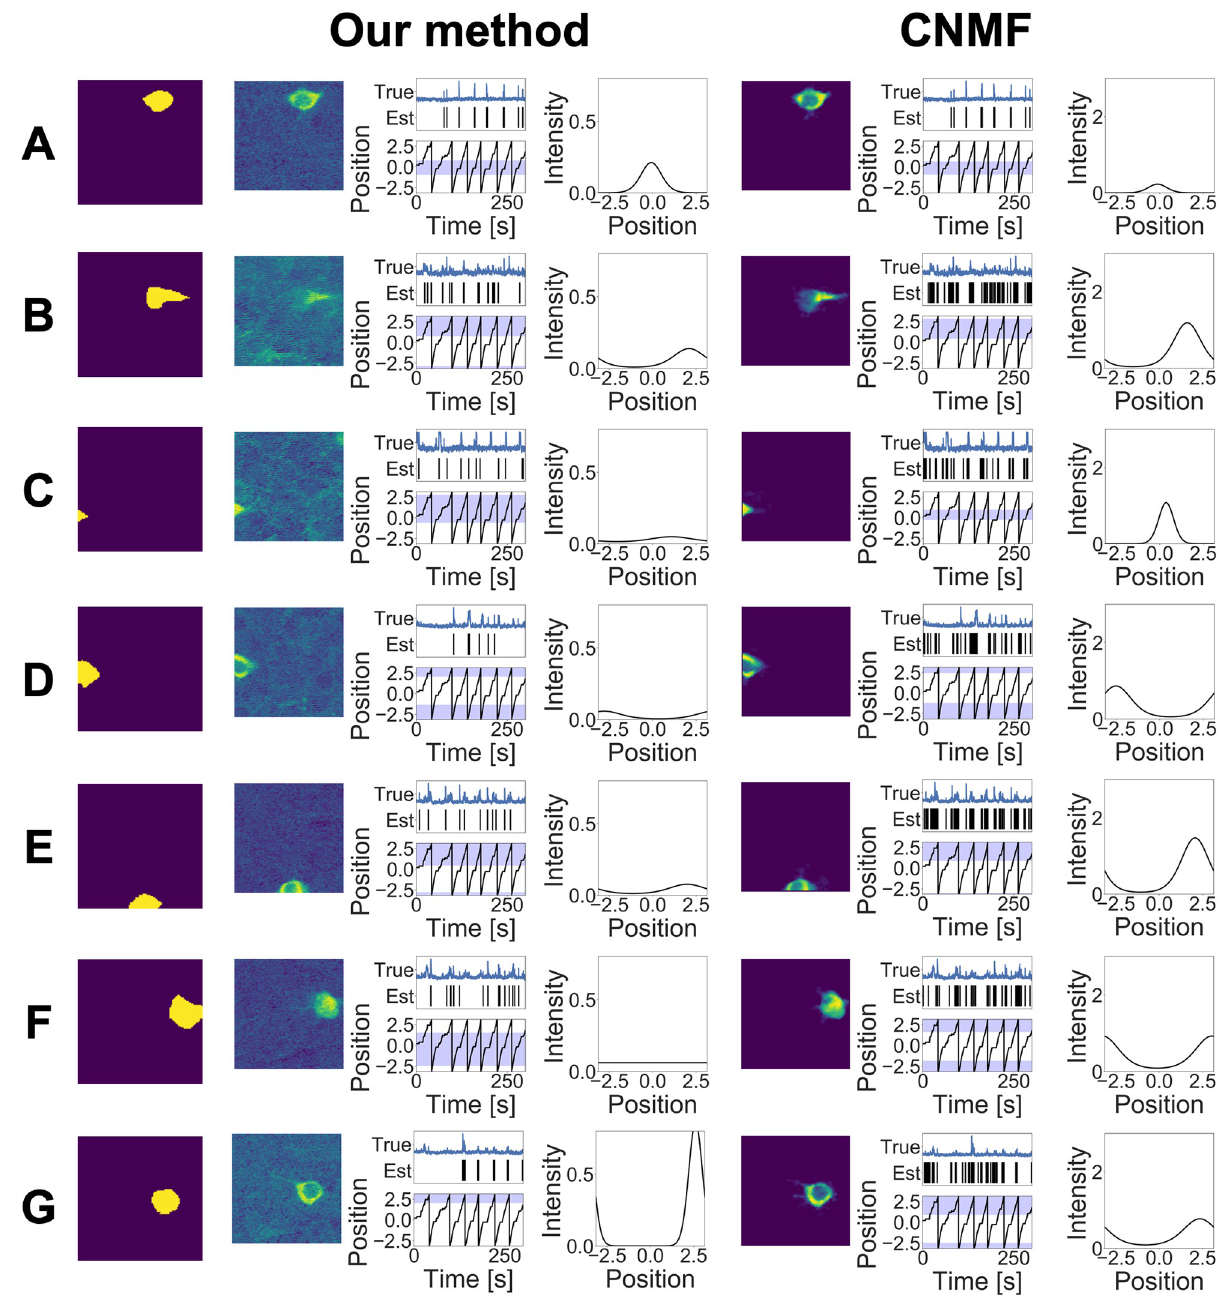
Fig 6. (A)–(G) Estimation results obtained by the two methods in the experimental study. The first column indicates the ground truths, the second column shows the components obtained by our method, and third column shows those obtained by CNMF. Each component consists of three images. (Left) Estimated cell shape. (Middle) Calcium trace, estimated spiking time, and receptive field. The blue line indicates the normalized calcium trace within the ROI, and each vertical line indicates the estimated index when the spike occurred. The black line plot shows the position of the mouse, and the blue band shows the receptive field decided by μ x and τ x . (Right) Estimated tuning